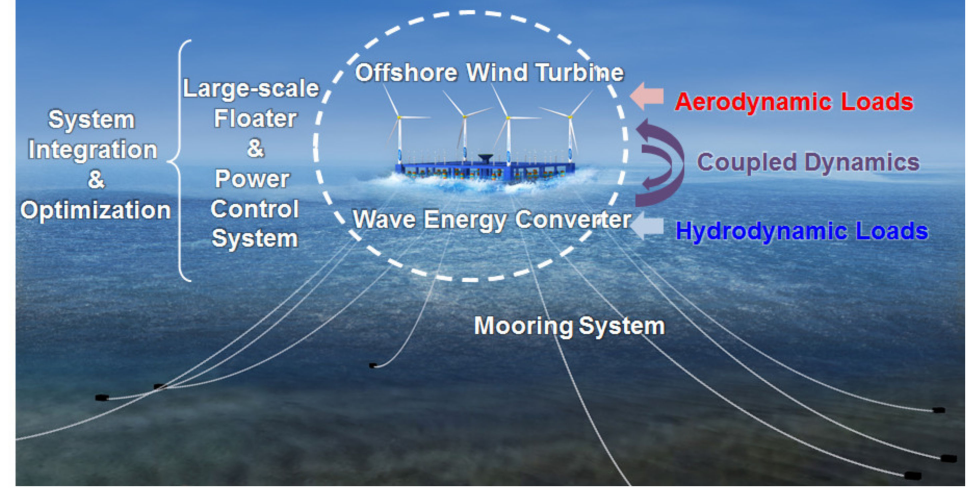
Figure 1. Concept of wave-offshore hybrid power-generation system